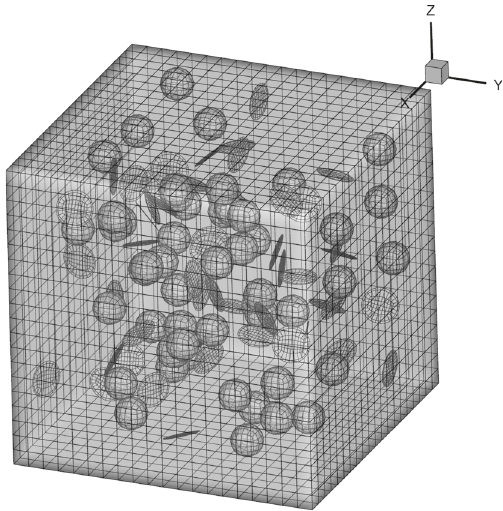
Figure 10: 𝐾 eff /𝐾 0 versus the microcrack’s and microvoid’s density.